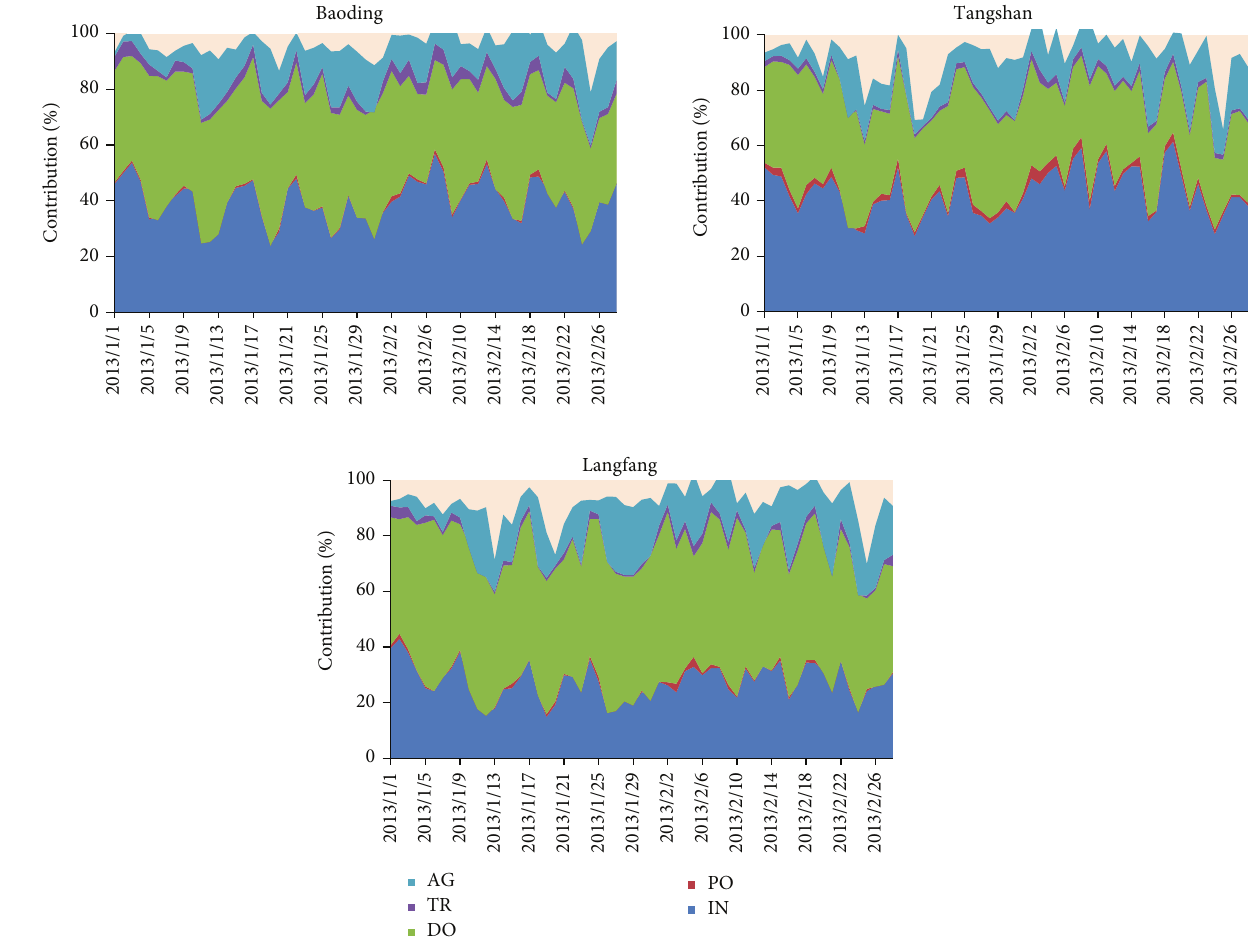
Figure 3: The contribution of sectors to PM 2.5 concentrations in Hebei from 1 January to 28 February